Question: Write a descriptive caption for this figure.
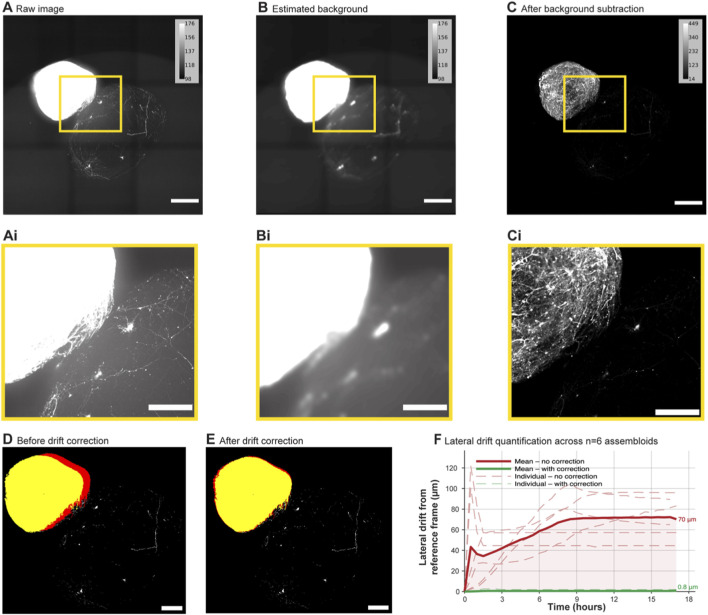
Answer: The pre-processing pipeline reduces background signal heterogeneity and corrects bulk lateral drift in 4D assembloid recordings. (A–C) Maximum intensity projections (z-MIP) of a representative assembloid (EYFP + cells) at a single timepoint: raw image data (A) , estimated background generated by 3D Gaussian filtering (FWHM: 64.3 × 64.3 × 424 µm) (B) , and background-subtracted output (C) . Intensity calibration bars are shown for each panel; panels A and B have matched windows (98-176) with narrow dynamic range; panel C is displayed over its native range (14-449). Yellow boxes indicate the region shown in Ai-Ci. (Ai-Ci) Zoomed view of the region indicated in A-C, displayed at identical brightness/contrast settings within the inset row. Equivalent results for the SOX10-tdTomato + channel are shown in Supplementary Figure S2 . (D,E) False-color overlay of the assembloid position at the first (yellow) and last timepoint (red) before (D) and after (E) drift correction, illustrating reduction in bulk lateral displacement. (F) Cumulative lateral drift magnitude from the reference frame as a function of elapsed time for n = 6 assembloids. Bold lines indicate group means; dashed lines indicate individual assembloid traces. Red: pre-processed but drift-uncorrected stacks; green: drift-corrected stacks. End-point mean values are annotated. Scale bars: 500 µm (A–C) , 250 µm (Ai–Ci) , 400 µm (D,E) .